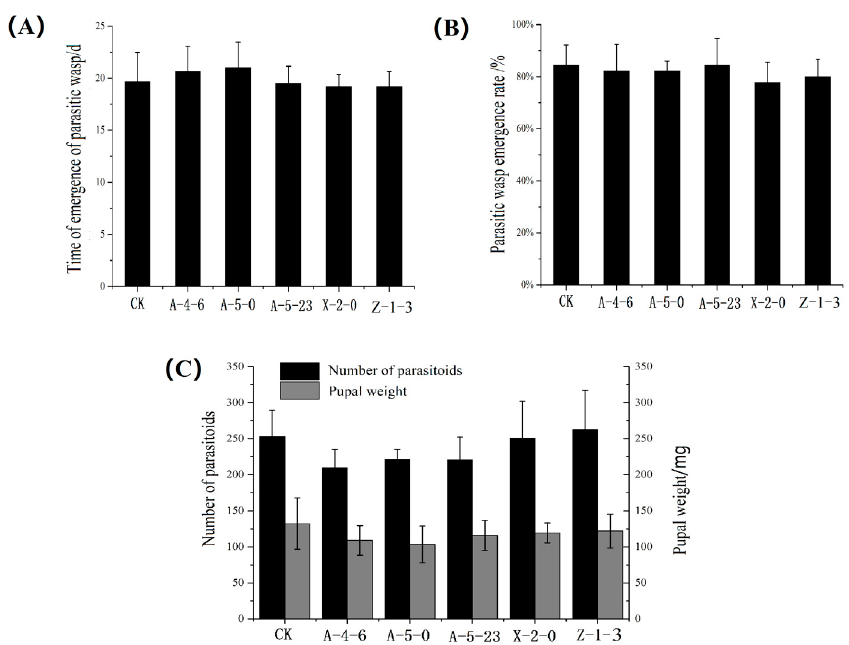
Figure 8. Effects of transgenic poplar on a parasitic natural enemy. ( A ) Emergence times of C. cunea . ( B ) Emergence rates of C. cunea . ( C ) Wasp output and pupa weight of the parasitoids.